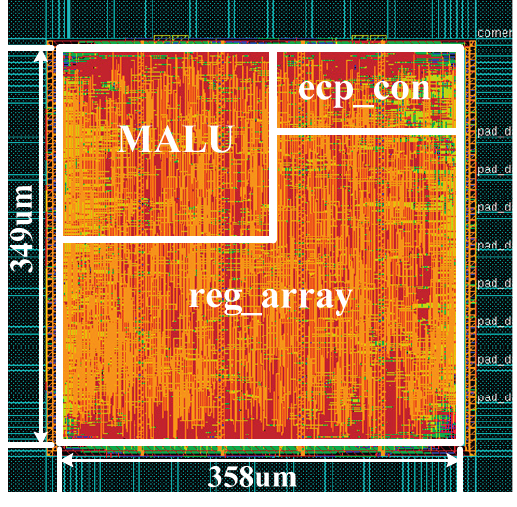
Figure 13. Final Layout Result.